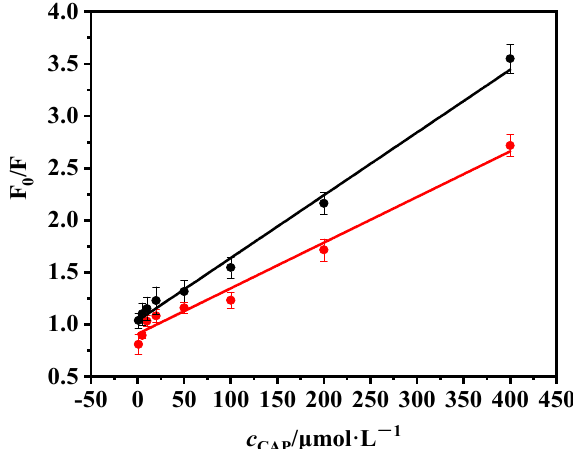
Figure 9. Stern-Volmer plots from MIP@SiO 2 @QDs ( a ) and NIP@SiO 2 @QDs ( b ) with CAP.